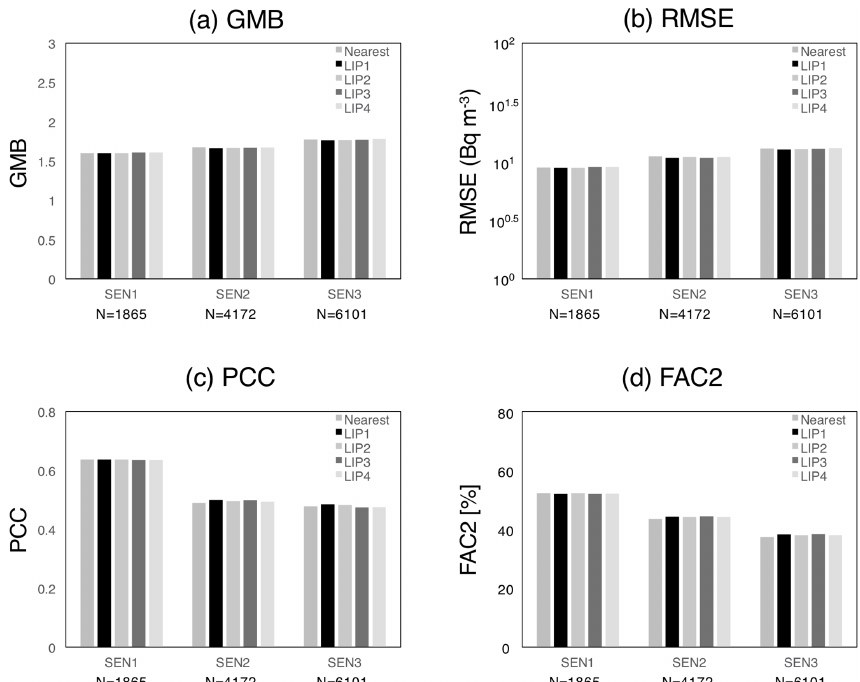
Figure 7. Statistical metrics (GMB, RMSE, PCC and FAC2) for the three sensitivity tests (SEN1, SEN2 and SEN3) as described in Ta- ble 3 using the five interpolation methods (nearest, LIP1, LIP2, LIP3 and LIP4) described in Table 2. The x axis represents the sensitivity experiments with the sampling number ( N